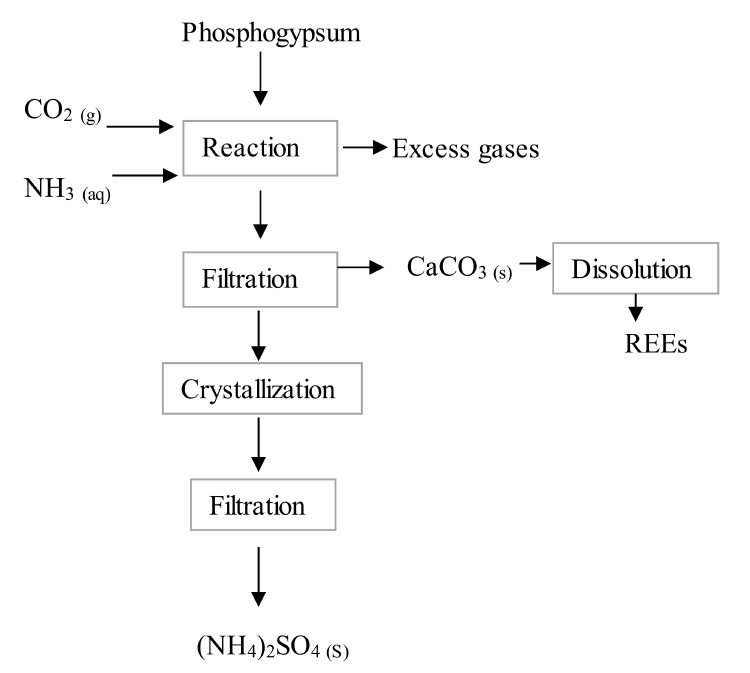
Figure 2. Mineral carbonation of phosphogypsum adapted and modified from